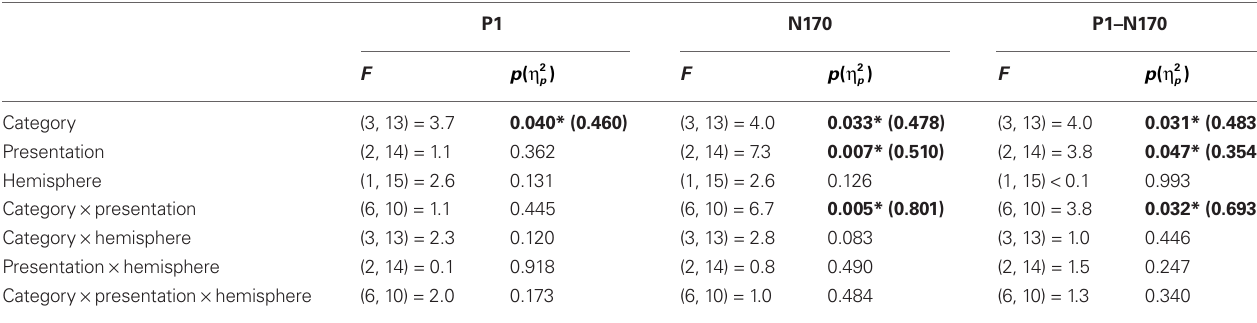
Table 3 | Statistical results of a 4 categories × 3 presentation conditions × 2 hemispheres repeated-measures MANOVA on the peak amplitude of the P1, N170, and P1 to N170 peak-to-peak